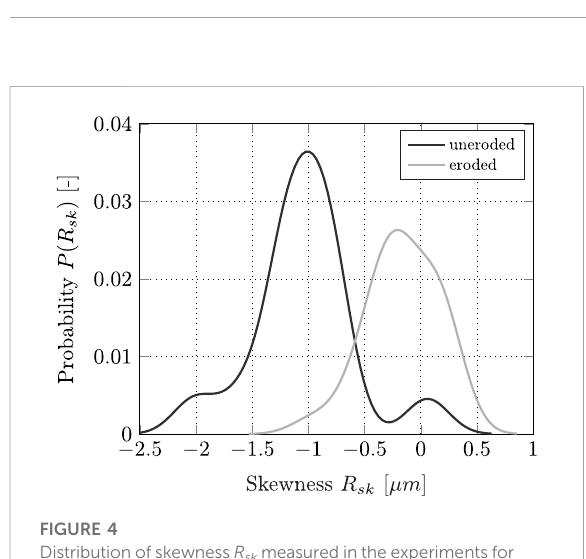
FIGURE 4 Distribution of skewness R sk measured in the experiments for the pre- and post-erosion